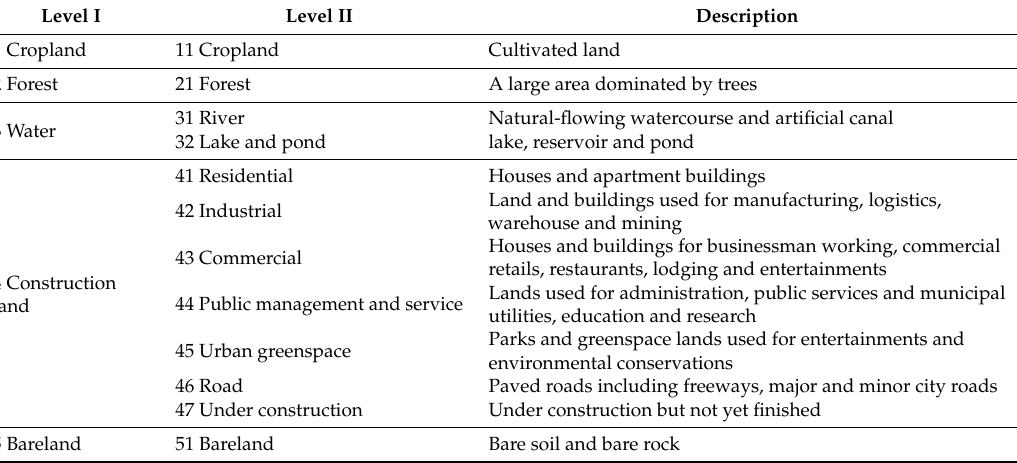
Figure 2. Technical schema in the land use data extracted from SPOT 6 images. Table 1. Land use classification scheme.